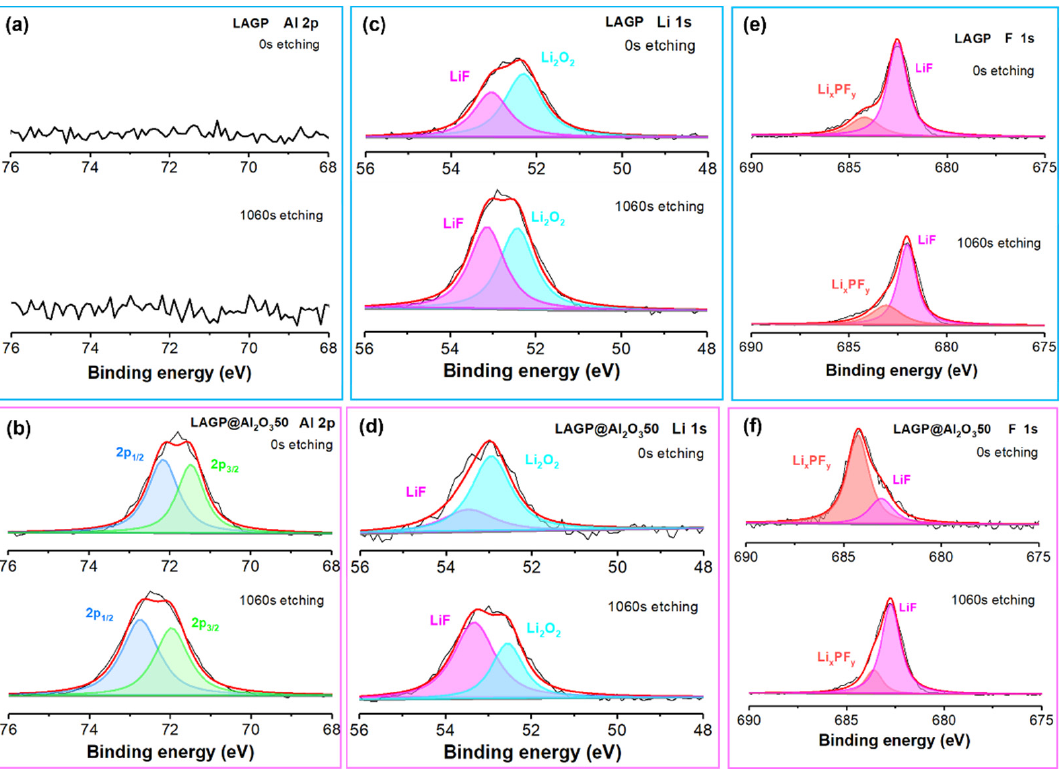
Figure 7. XPS spectra of ( a , b ) Al 2p, ( c , d ) Li 1s, ( e , f ) F 1s of the surface of LAGP and LAGP@Al 2 O 3 50 after cycling test.